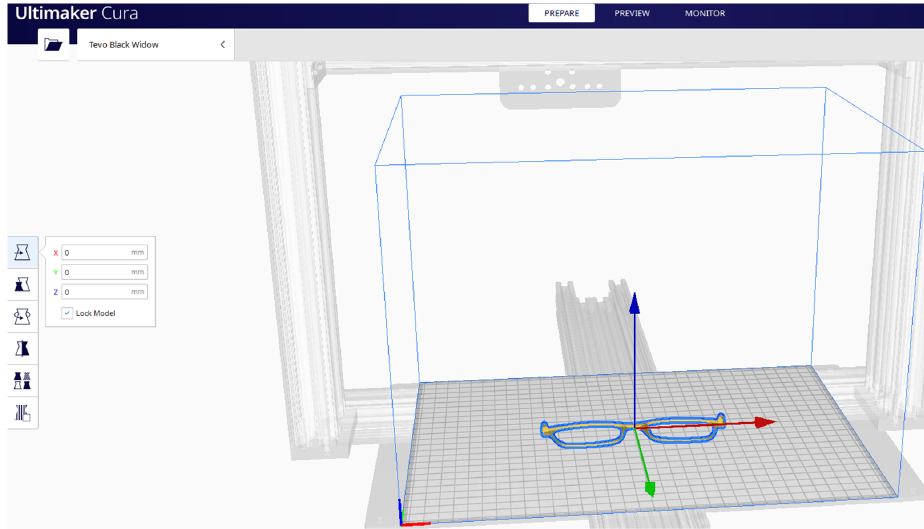
Figure 8. Spectacles frame parameters in the Ultimaker Cura ® .